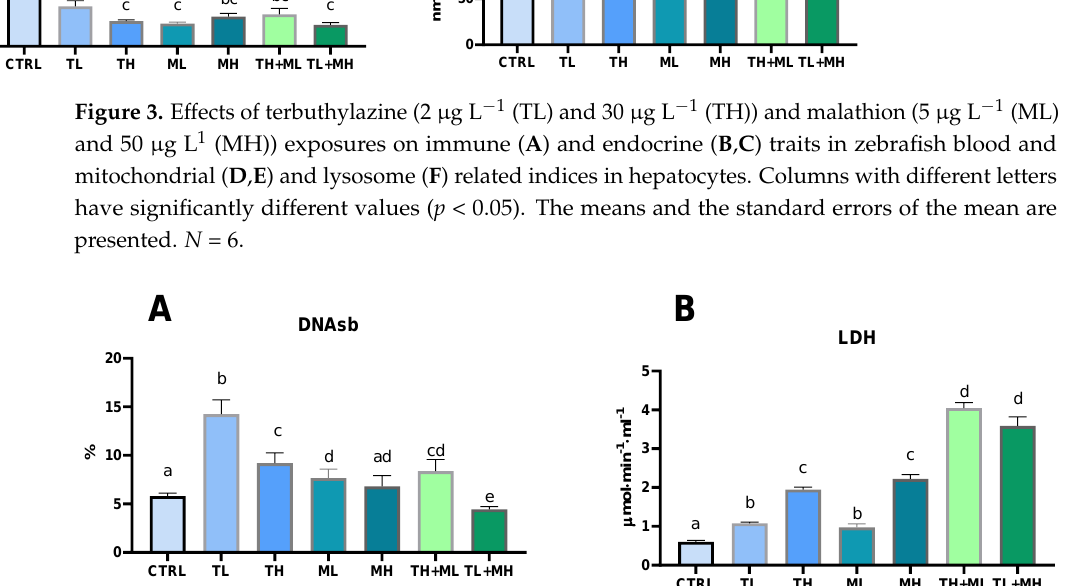
Figure 4. Effects of terbuthylazine (2 µ g L − 1 (TL) and 30 µ g L − 1 (TH)) and malathion (5 µ g L − 1 (ML) and 50 µ g L − 1 (MH)) exposures on the ratio of DNA strand breaks in hepatocytes and lactate dehydrogenase leakage in blood of zebrafish. ( A ) DNA strand breaks; ( B ) Lactate dehydrogenase. Columns with different letters (a–e) have significantly different values ( p < 0.05). The means and the standard errors of the mean are presented. N = 6.